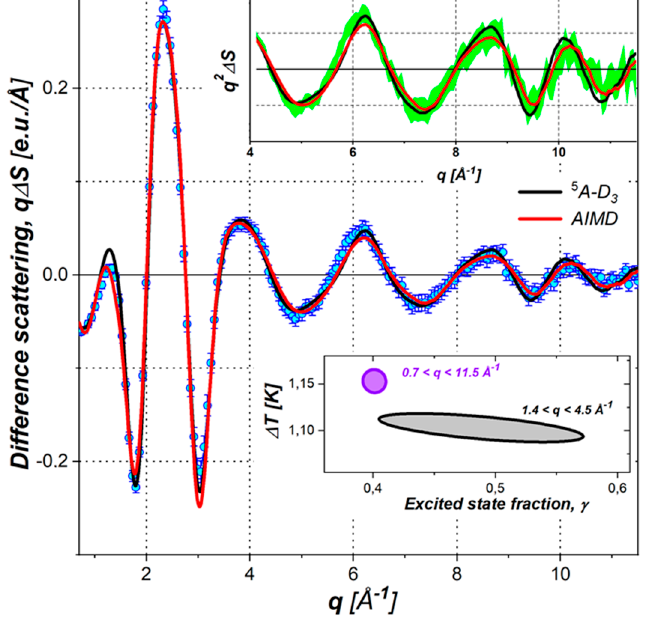
Figure 6. Pump-probe di ff erence WAXS signal from an aqueous solution of [Fe(bpy) 3 ] 2 + collected at the ESRF synchrotron with 25.2 keV X-ray photons at 100 ps time delay. The experimental curve (cyan circles and green trace in the top inset) was fitted using a LCF and solute structure delivered by the AIMD (red curve) or DFT ( 5 S-D 3 state, black curve). The high spatial resolution enabled by the large q -range allows for selecting the best suited structural models of the solution (see top inset) and better decorrelation of the solute (excited state fraction) and the solvent (bulk temperature rise) observables as compared to the case of the limited q -range (see the bottom inset).